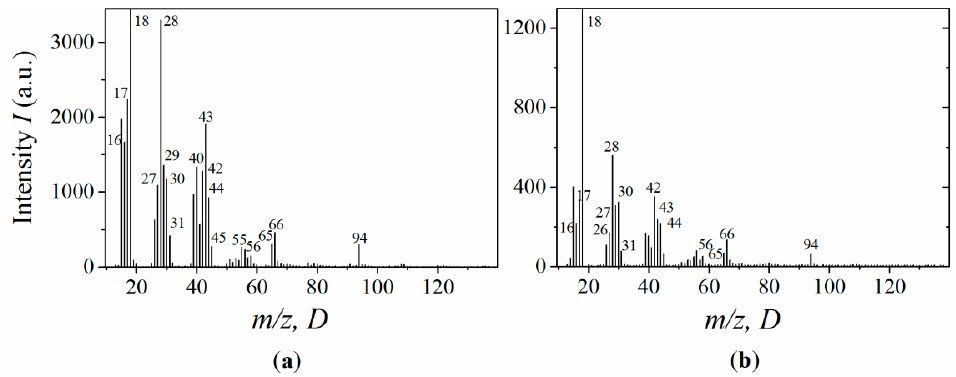
Figure 6. Mass spectra of the neat epoxy ( a ) and MLG composites of 1% ( b ). MLGs at temperatures